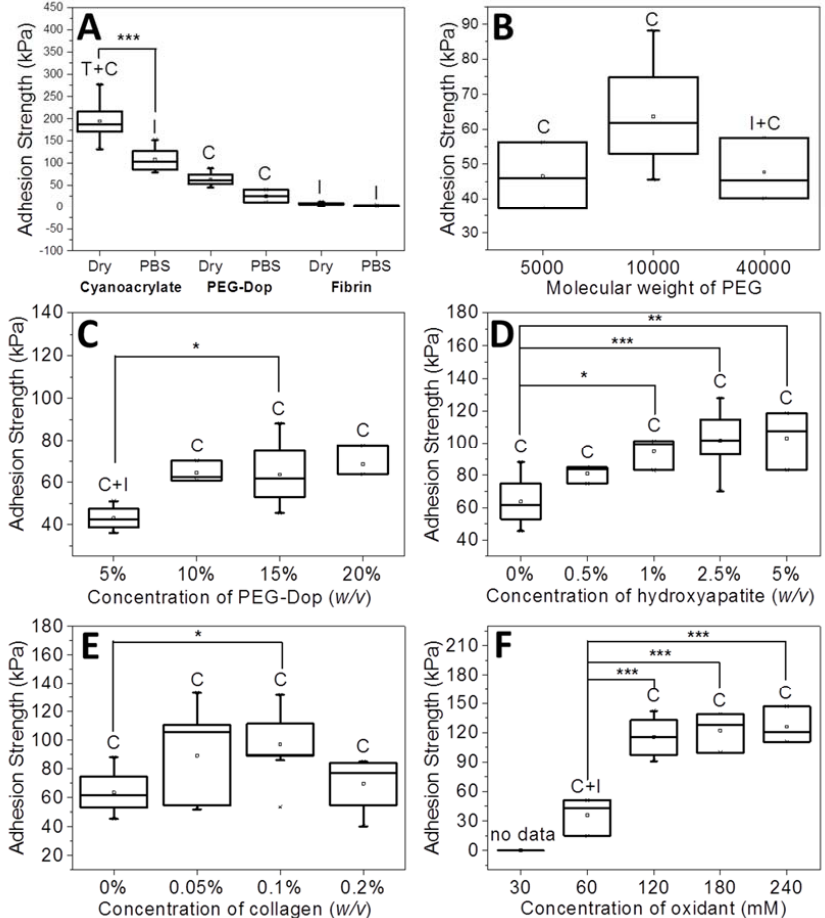
Figure 1. Adhesion strength of 10 kPa poly(ethylene glycol) O , O ’, O ’’, O ’’’ ‐ tetra(acetic acid dopamine) amide (PEG ‐ Dop)/NaIO 4 ‐ based glues as function of the concentration of individual components in the gluing mixture. ( A ) Dry and wet test conditions (as compared with commercial tissue glues); ( B )